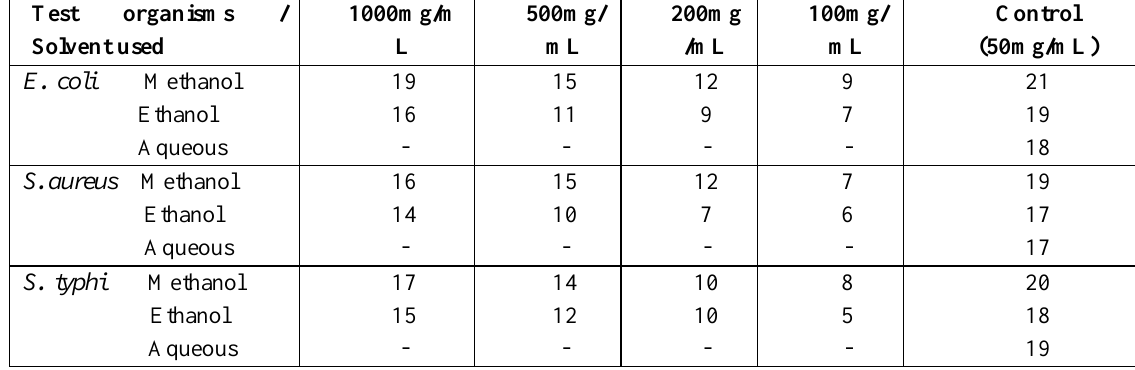
Table 2. Antibacterial activity of methanolic, ethanolic and aqueous leaf extract on the test organisms in milliliter (mm).